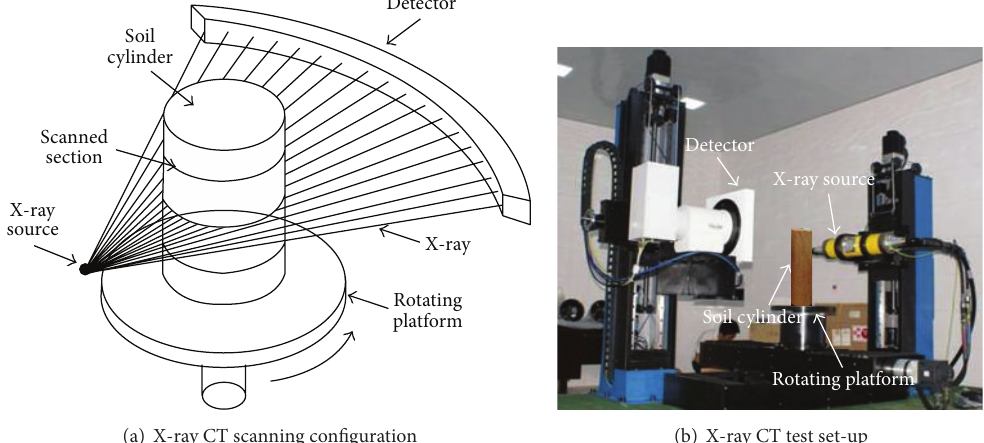
Figure 1: Configuration of X-ray CT scanning test.